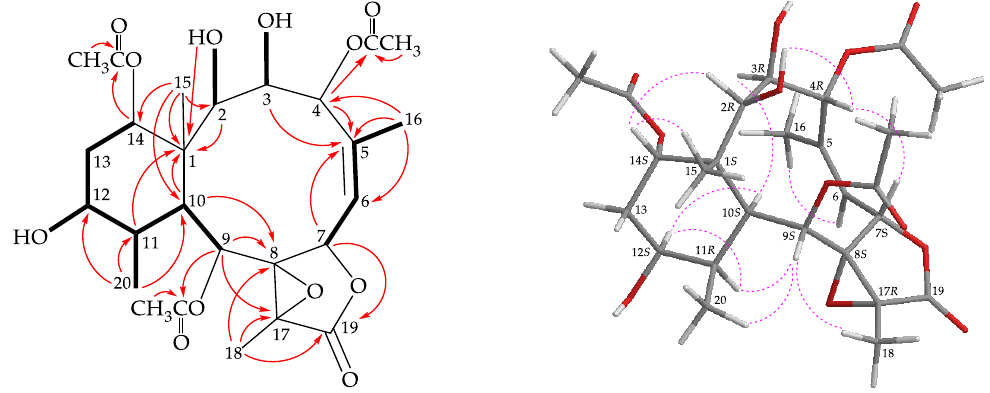
Figure 4. The COSY ( ) correlations, selective HMBC ( ), and protons with key NOESY Figure 3. The COSY ( Figure 2. The COSY ( ) correlations, selective HMBC ( ), and protons with key NOESY ) correlations, selective HMBC ( Figure 3. The COSY ( ) correlations, selective HMBC ( ), and protons with key NOESY ) correlations, selective HMBC ( ), and protons with key NOESY correlations ( ) of 3 . correlations ( ) of 1 . ) of 2 correlations ( ) of 2 . correlations ( ) of 2 .